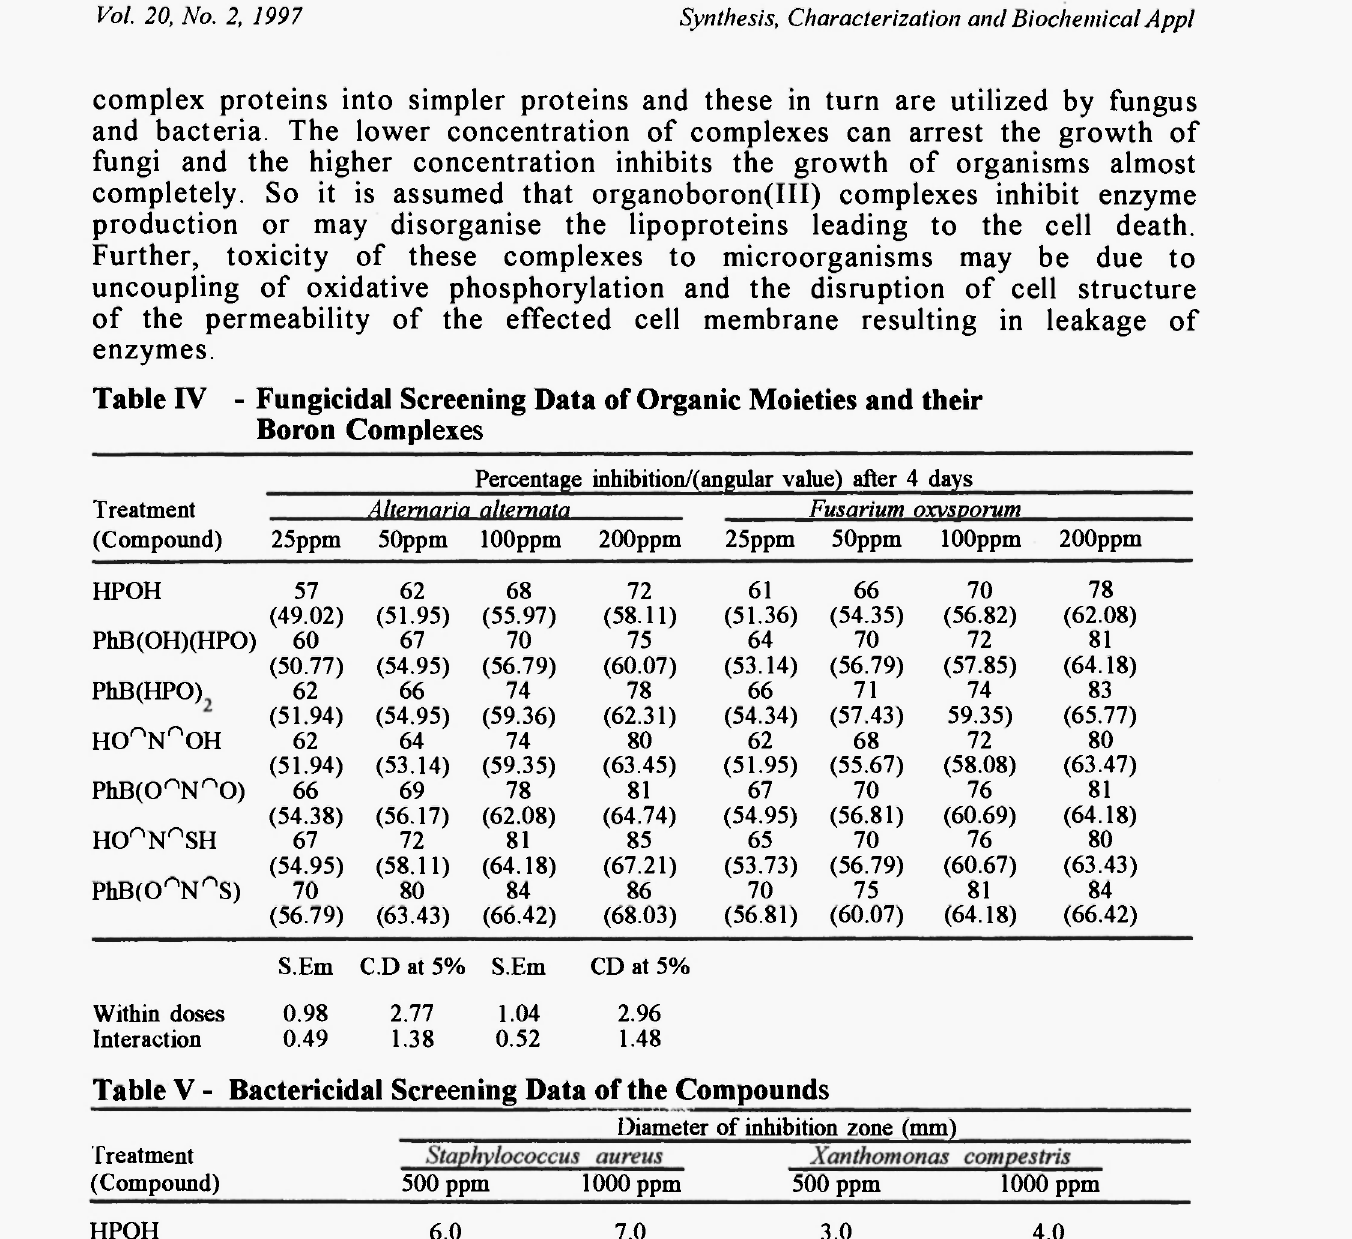
Table V - Bactericidal Screening Data of the Compounds